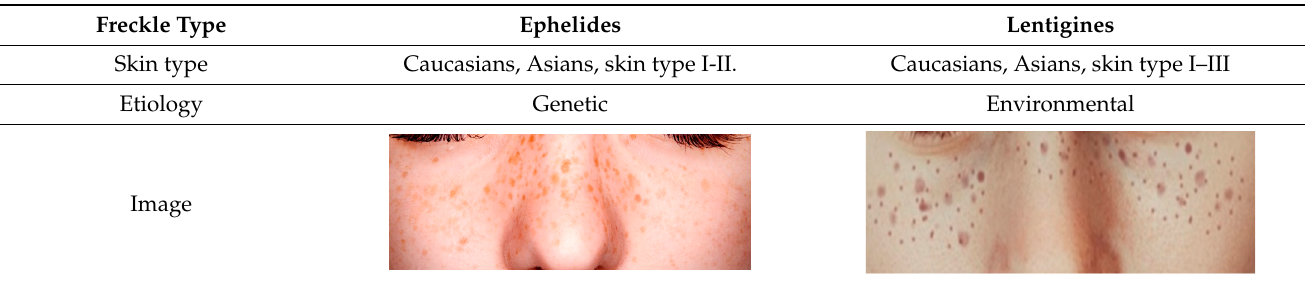
Table 3. Types of Face Wrinkle in training sets [20].